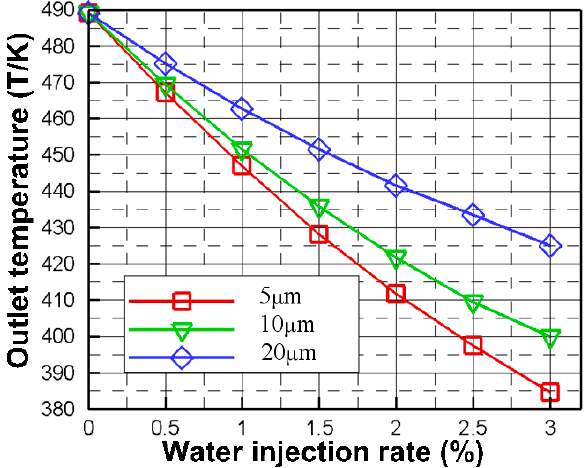
Figure 15. Comparison of outlet temperature under dry and water injection cases.